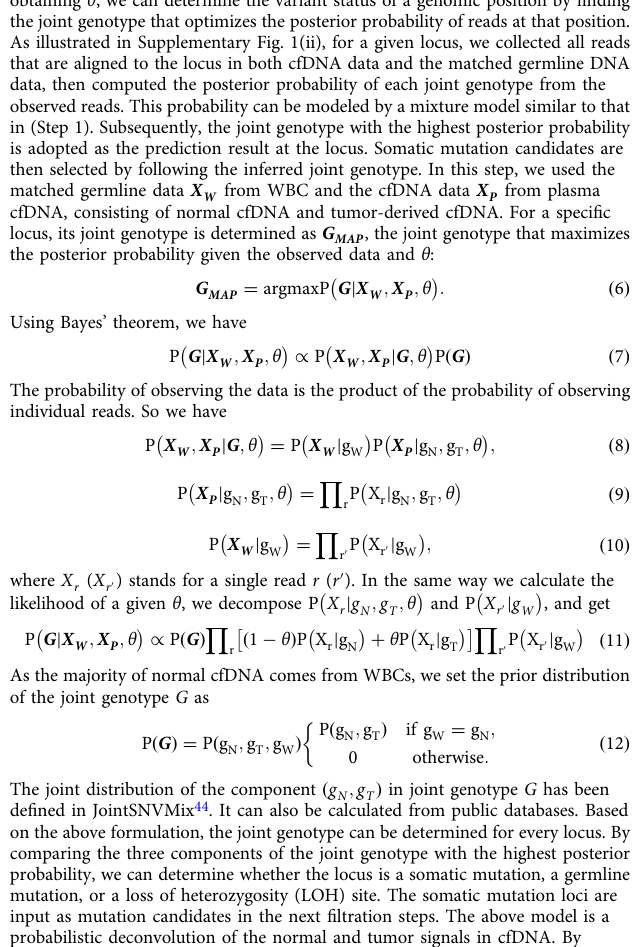
Table 7). Genome sequences around the mutation candidates were extracted from hg19 using bedtools 46 . All categorical features were expanded using one-hot encoding method. We used the parameters of the random forest model as follows: (1) the number of decision trees is 100, (2) the maximum tree depth is 10, (3) imbalanced classes were handled by setting the class weights with option balanced, and (4) other parameters were left at their default values. Two random forest classi fi ers (for overlapping read pairs and non-overlapping read pairs) were trained on read pairs extracted from the WES data (SRR6708941) using RandomForestClassi fi er from the python library scikit-learn 47 . Read pairs from SRR6708920 were only used for validating the model. The trained classi fi ers are saved in the cfSNV code package (see "Code